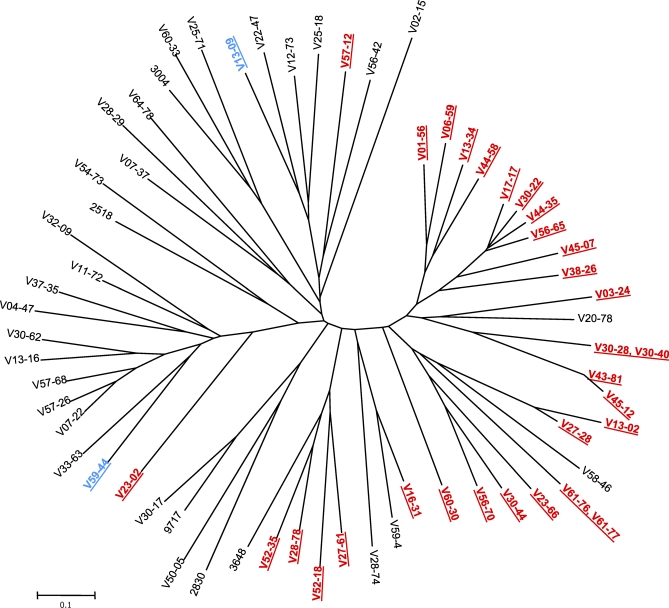
Genotypic Relatedness of 32 ITZ+ A. fumigatus Isolates and 32 ITZ− ControlsThe numbers are the identification numbers of the individual isolates. The ITZ+ A. fumigatus with the L98H substitution and a tandem repeat in the promoter region of the cyp51A gene are underlined and printed in red. The ITZ+ isolates with other or unknown resistance mechanisms are underlined and printed in blue. The ITZ− isolates are printed in black.